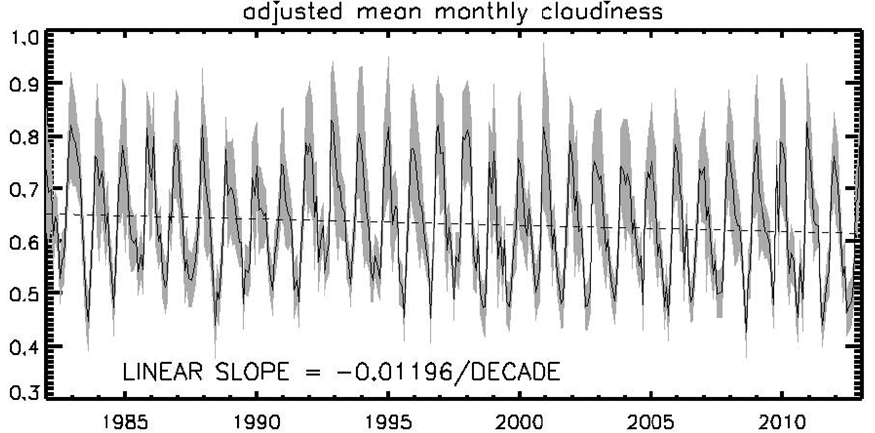
Figure 2. The diurnally corrected time series of the monthly mean cloud cover over the Great Lakes region between 1982 and 2012. The geographic region is bounded by 55°N and 35°N latitude and between − 75° and − 95° longitude. The thin black line is the mean and the gray shade the uncertainty. Uncertainty was calculated as the standard deviation of daily values for each